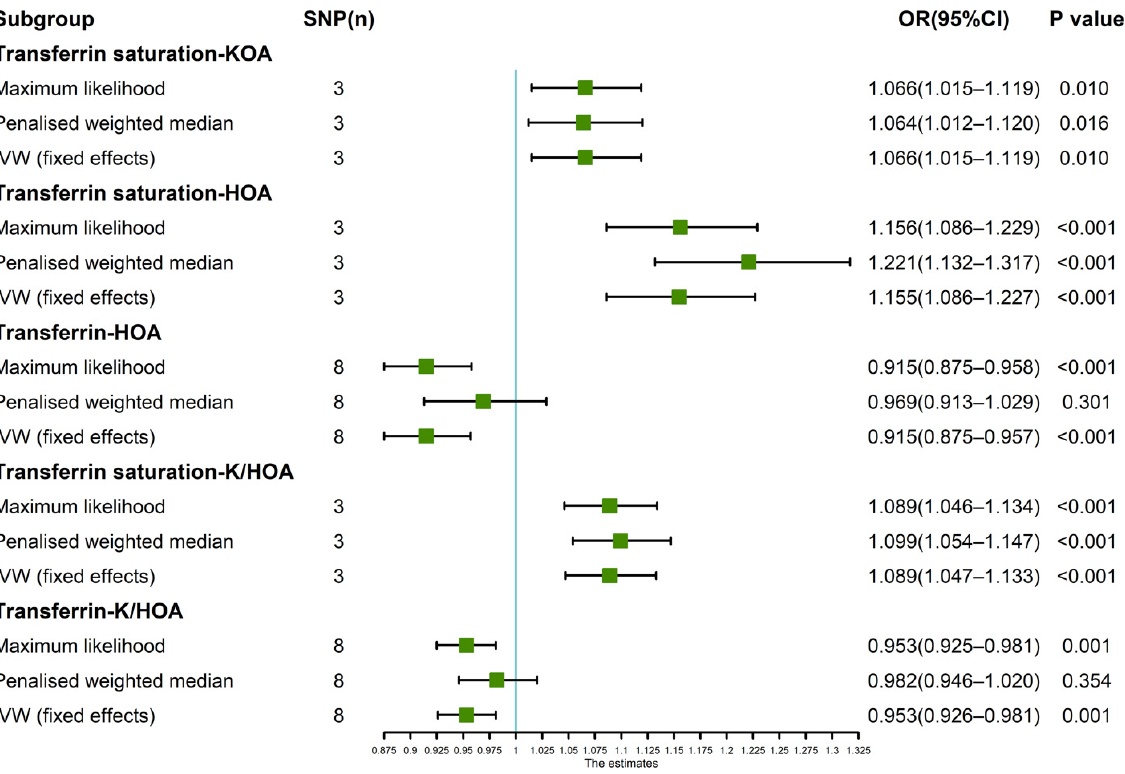
Figure 4. Estimated causal effects between iron status indicator and OA using different MR meth- ods.